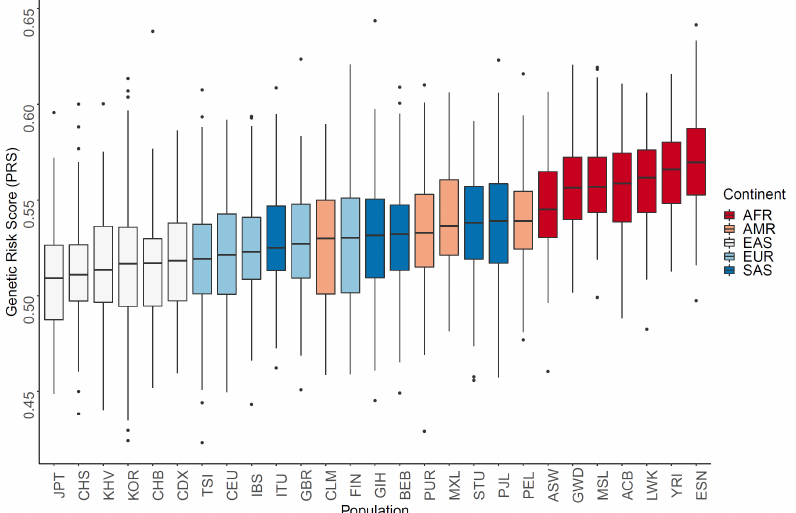
Figure 2. Polygenetic risk score (PRS) calculations of prostate cancer (PCa) using related single-nucleotide polymorphisms. The genetic risk scores calculated from allele frequencies for PCa were the highest in Africans, followed by Europeans and East Asians.(ACB: African Caribbean in Barbados; ASW: African ancestry in the Southwest USA; BEB: Bengali in Bangladesh; CDX: Chinese Dai in